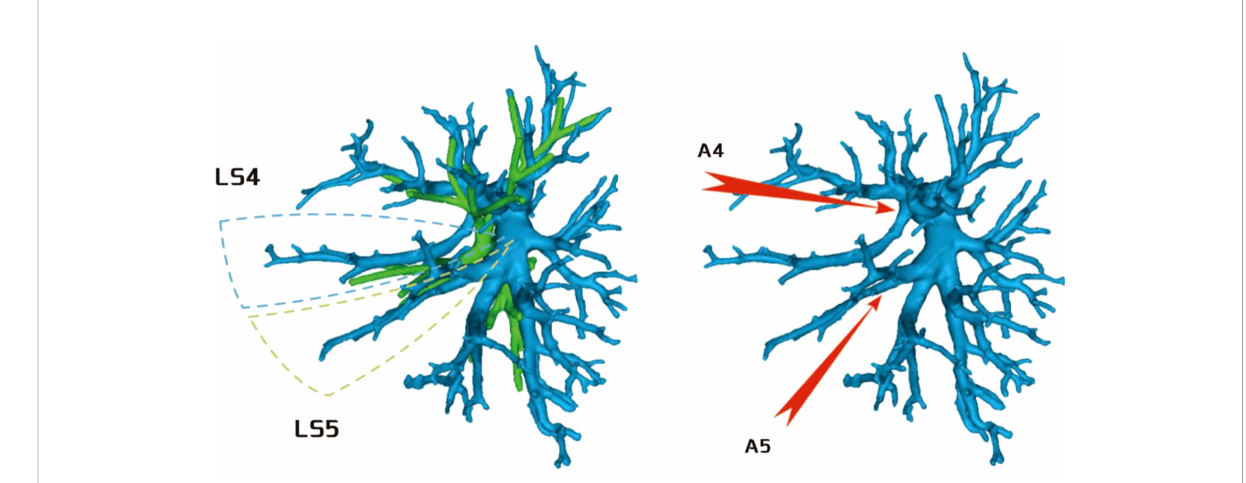
FIGURE 8 A4 originated from the mediastinal side of the lingular bronchus, and A5 originated from the oblique cleft side of the lingular